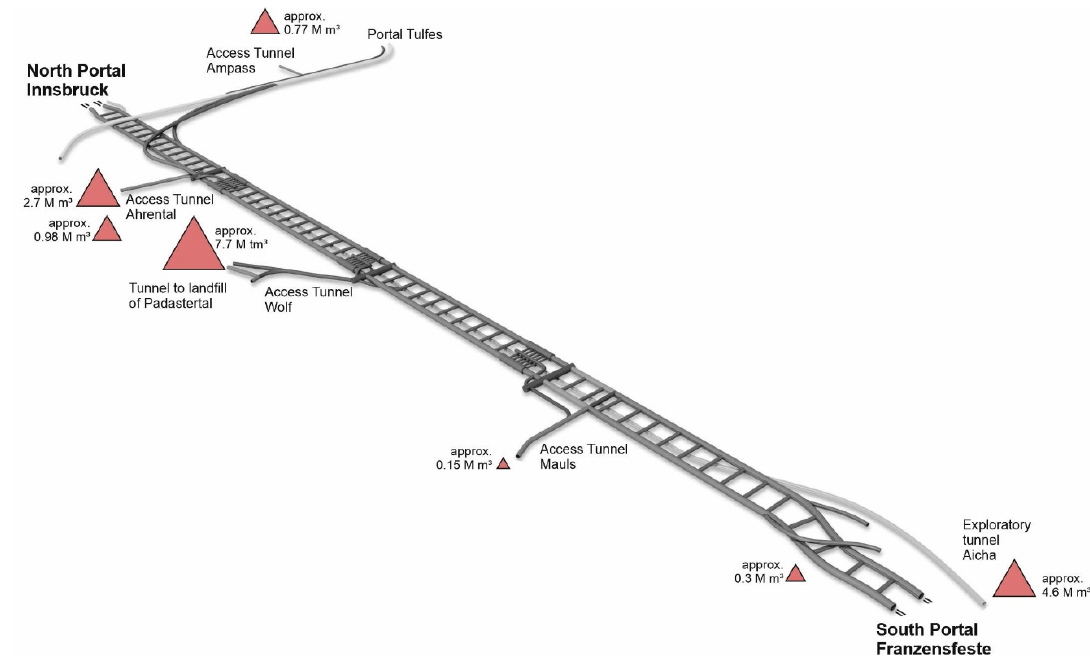
Figure 1. Planned landfill sites along the route of the Brenner Base Tunnel, cubatures in million cubic metres according to [28].